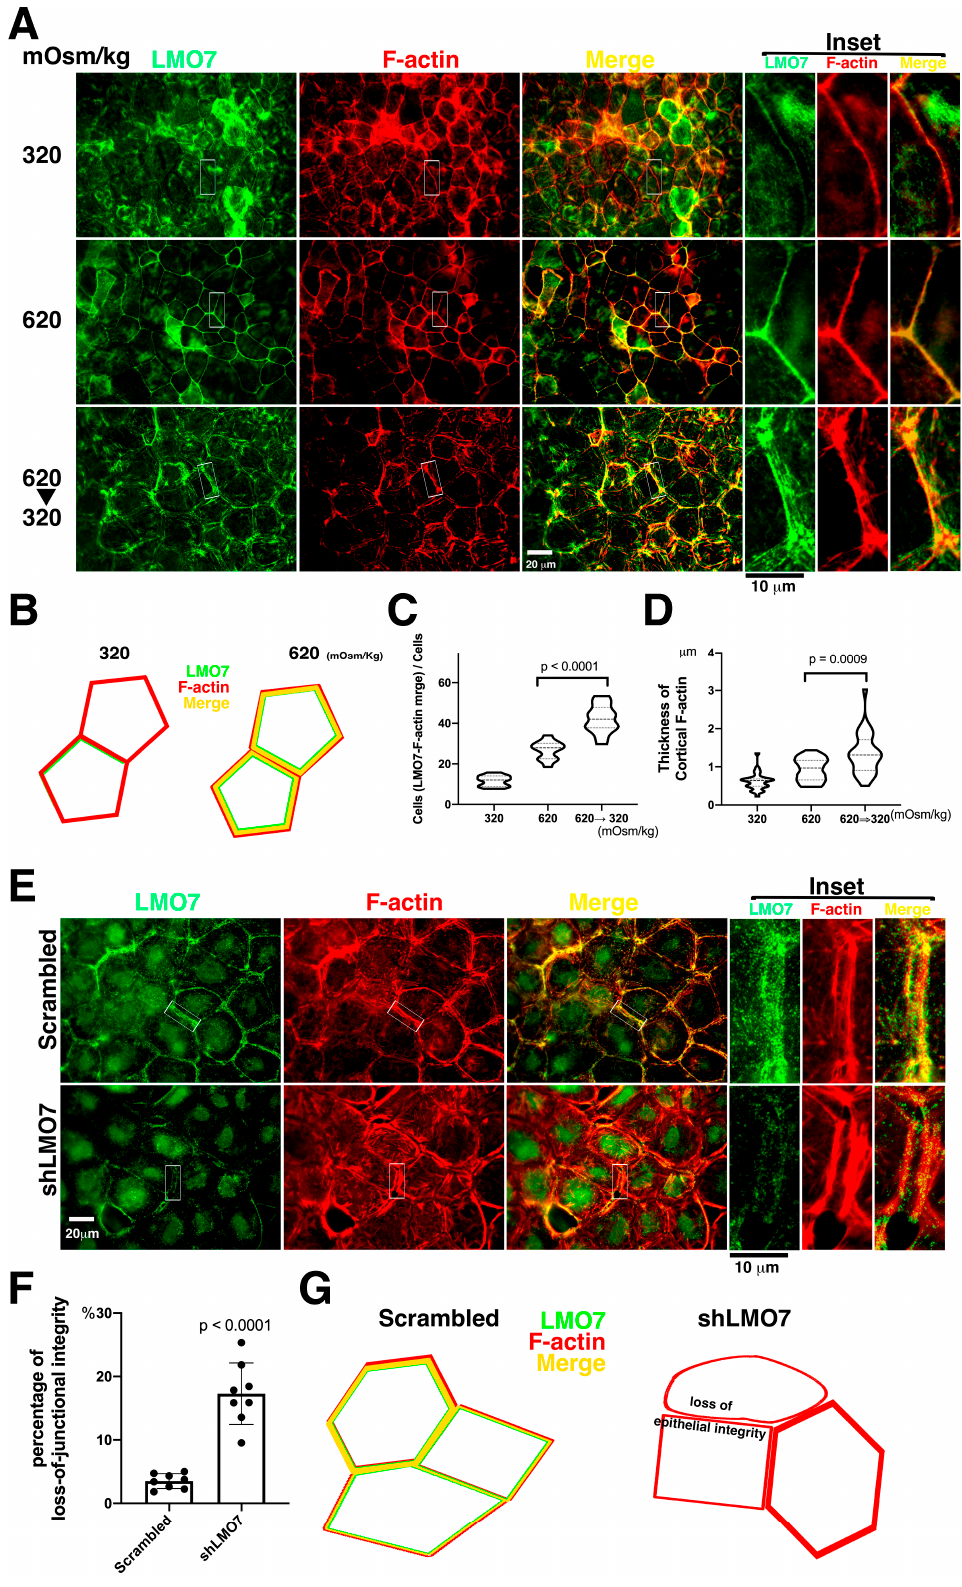
Figure 3. Effect of LMO7 depletion on junctional integrity is susceptible to osmotic pressure challenge. ( A ). The epithelial sheets are cultured in isotonic, hypertonic, and 620/320 mOsm/kg alternating medium. F-actin structures (Red) and LMO7 (Green) distributions are visualized in the epithelial